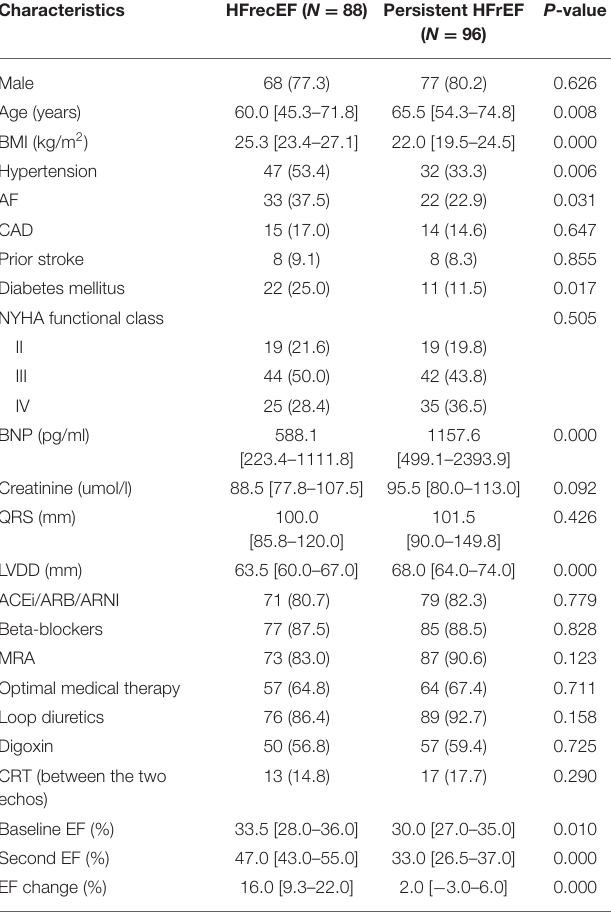
TABLE 3 | Clinical characteristics of patients between persistent HFrEF and HFrecEF group.